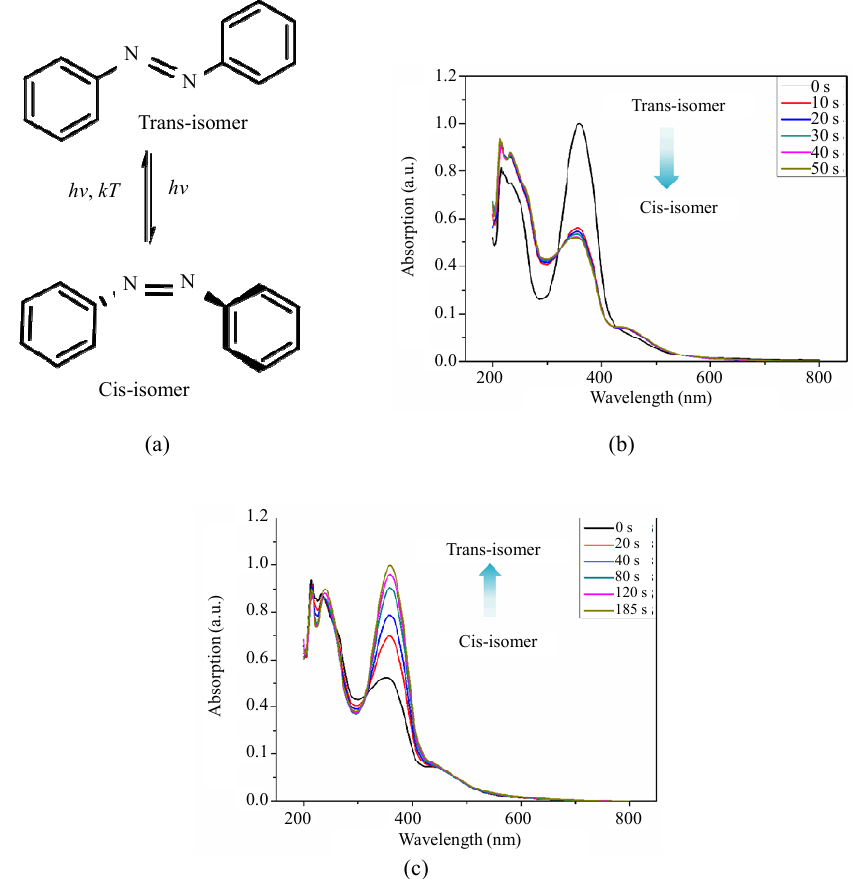
Fig. 2 Cis-trans isomerism: (a) photo-induced isomerization of the vesicles, (b) absorption spectra of the vesicles under UV irradiation, and (c) visible of light